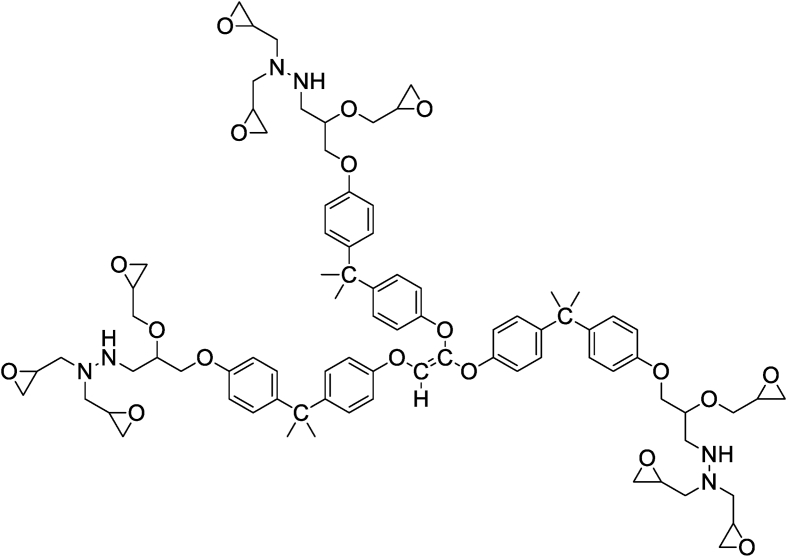
Structure of NGTHTPTBAE [43].